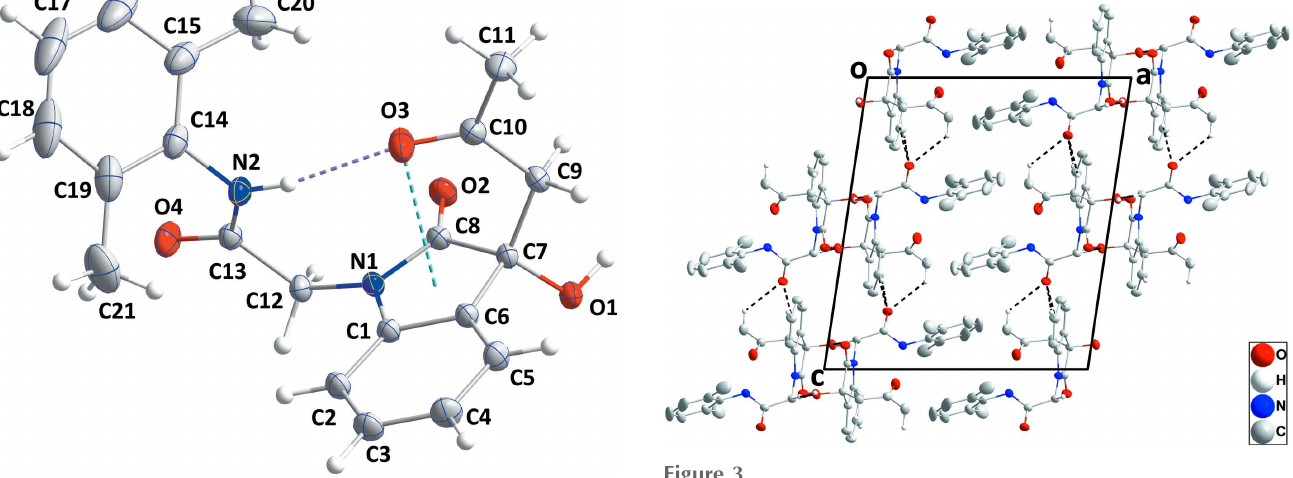
Figure 1 The title molecule with labeling scheme and 50% probability ellipsoids. The intramolecular N—H (cid:2)(cid:2)(cid:2) O hydrogen bond and C O (cid:2)(cid:2)(cid:2) ring inter- action are depicted, respectively by violet and light-blue dashed